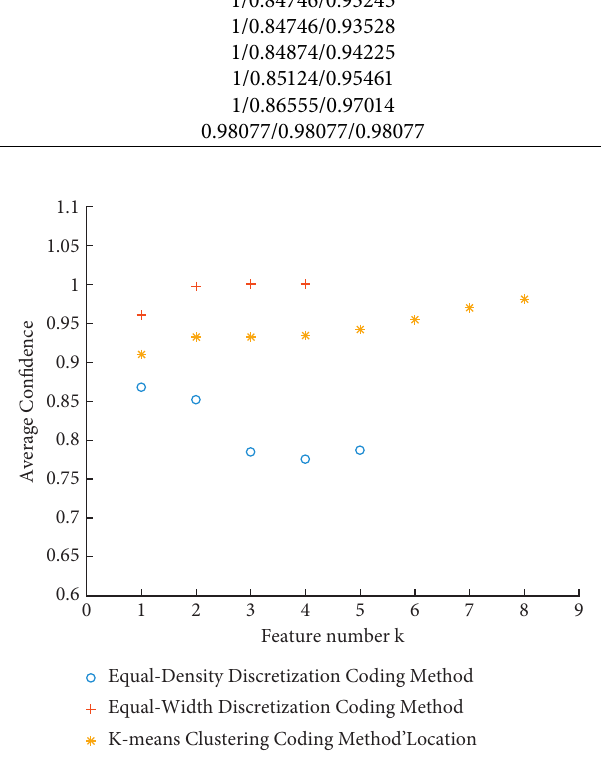
Figure 20: Average confidence of different feature state coding